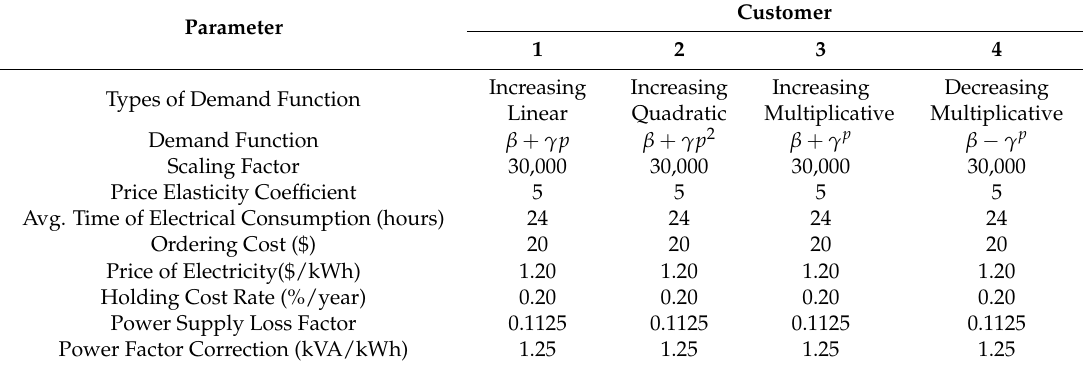
Table 1. Customer Data.